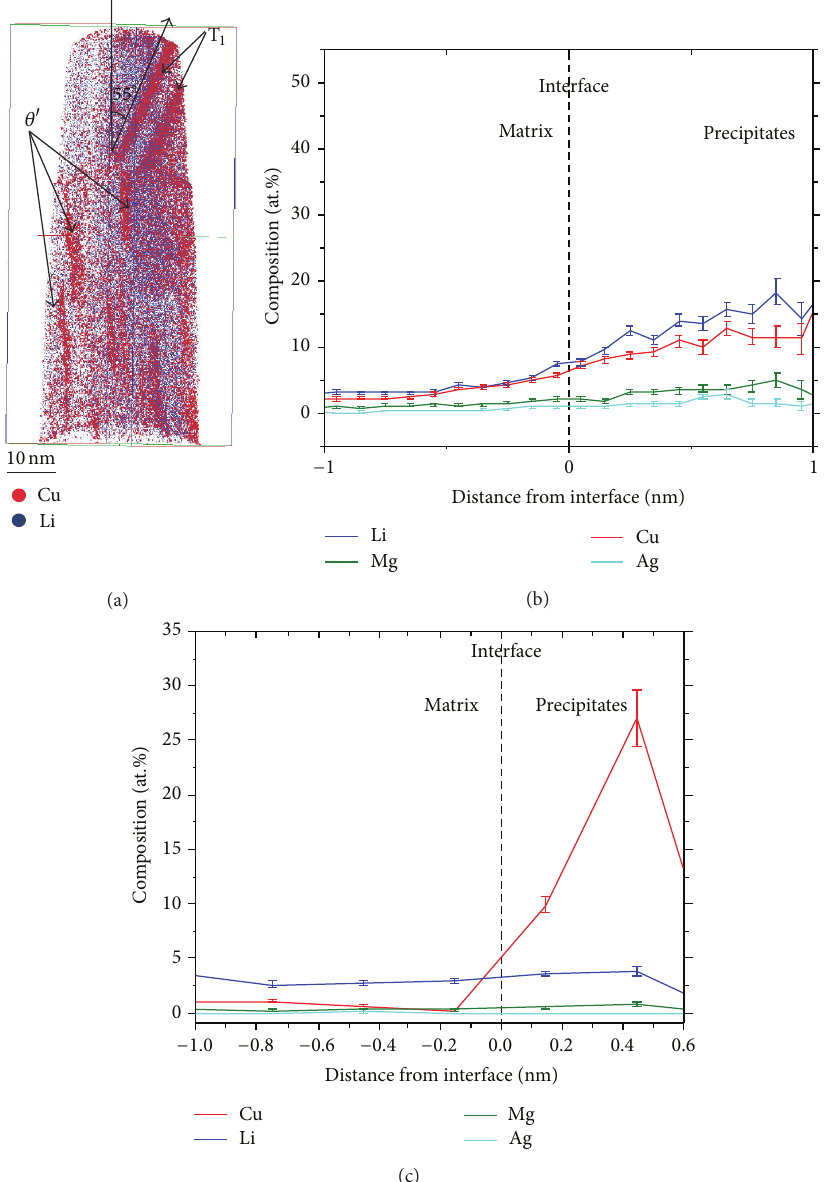
Figure 3: LAWATAP analysis of the microstructure at 30 K and 20% of pulse fraction. (a) Reconstructed volume showing the distribution of the T 1 and 𝜃 󸀠 phases. (b) Corresponding proxigram composition profile for the T 1 platelet indicating chemical composition of ( 11 ± 1 ) at.% Cu, ( 13 ± 1 ) at.% Li, ( 3 ± 1 ) at.% Mg, and ( 1.5 ± 0.4 ) at.% Ag. (c) Corresponding combined proxigram composition profile for the 𝜃 󸀠 platelet with a chemical composition of ( 27 ± 3 ) at.% Cu, ( 3.8 ± 0.2 ) at.% Li, and ( 0.7 ± 0.2 ) at.%